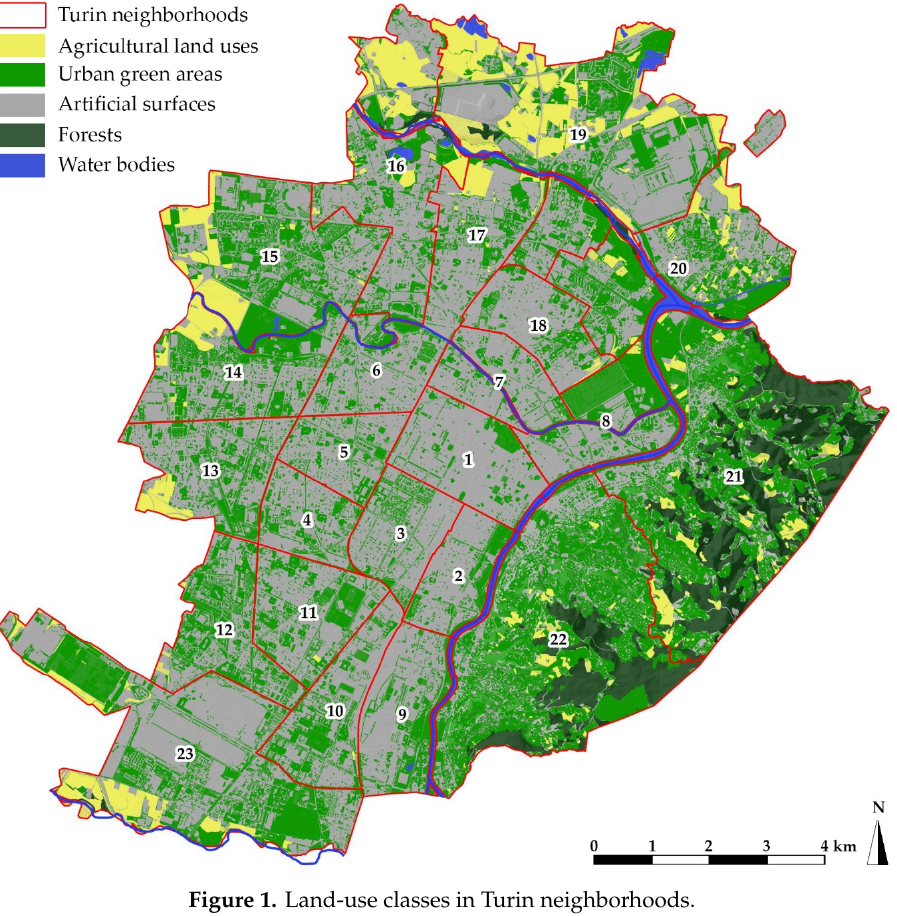
Figure 1. Land-use classes in Turin neighborhoods. Forests 2020 , 11 , x FOR PEER REVIEW